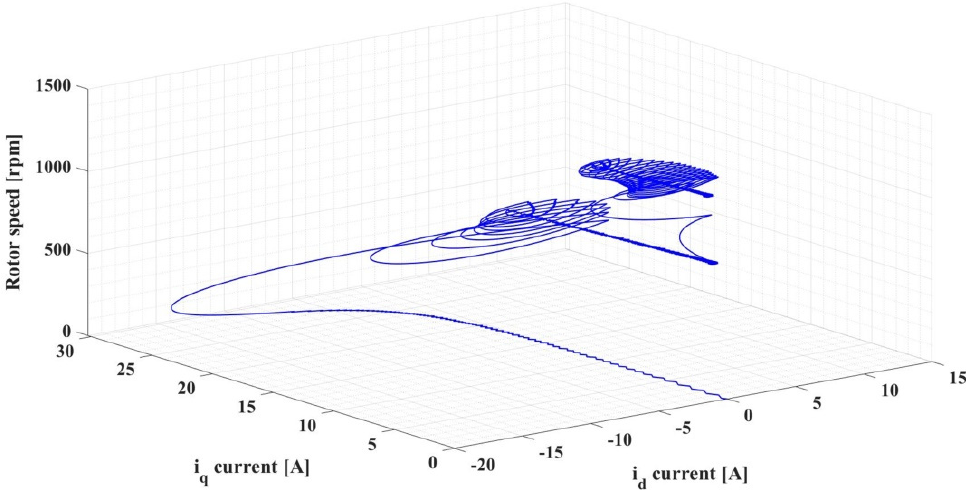
Figure 19. Image of the state space for PMSM variable structure with switching signal type 1: rotor